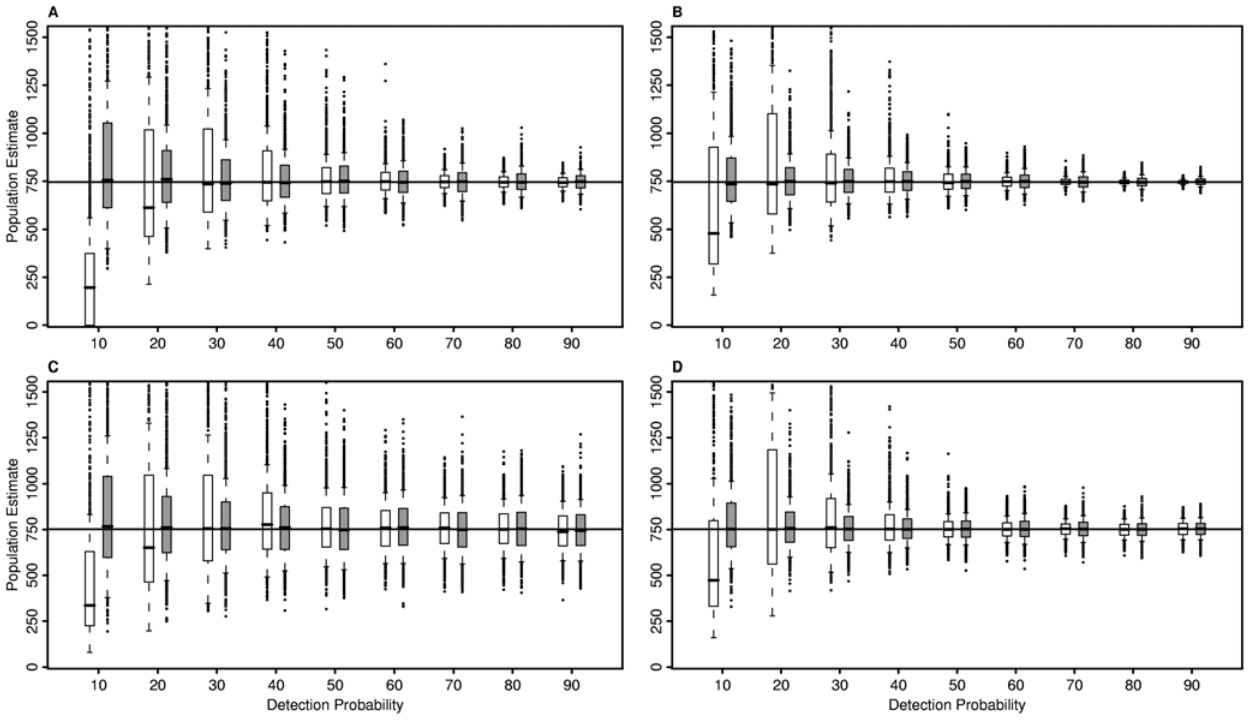
Figure 1. Population estimates for varying survey proportions. Population estimates were obtained based on the double observer and double sampling methods for 1,000 simulations each for the low clustered population with survey proportions of 25% and 75% (Panels A and B, respectively) and for the high clustered population with survey proportions of 25% and 75% (Panels C and D, respectively). White indicates the double observer method; gray indicates the double sampling method. Horizontal lines show true population sizes. The double observer method generally produced biased estimates when the detection probability was below 30%. doi:10.1371/journal.pone.0003047.g001 and 2). For example, for the HC population of 751 birds, with 25% of the area surveyed and a detection probability of 70%, DO population estimates ranged from 411 to 1,143 birds, whereas for the